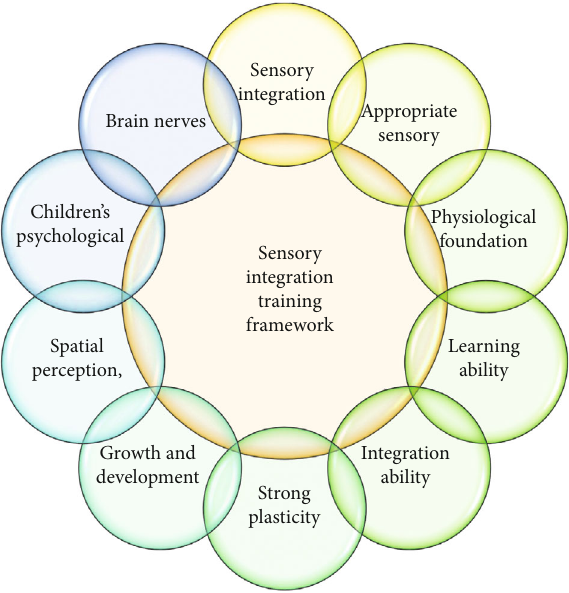
Figure 1: Sensory integration training